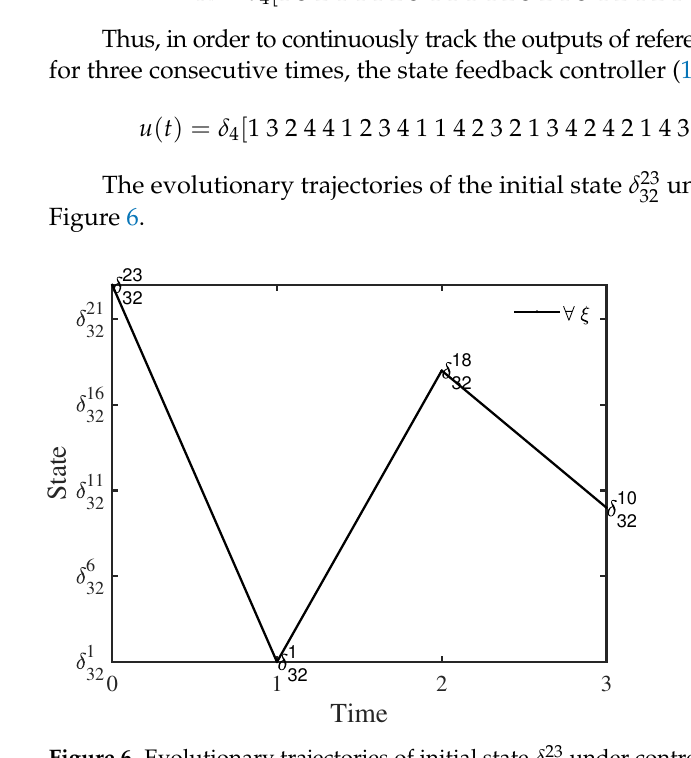
under control 32